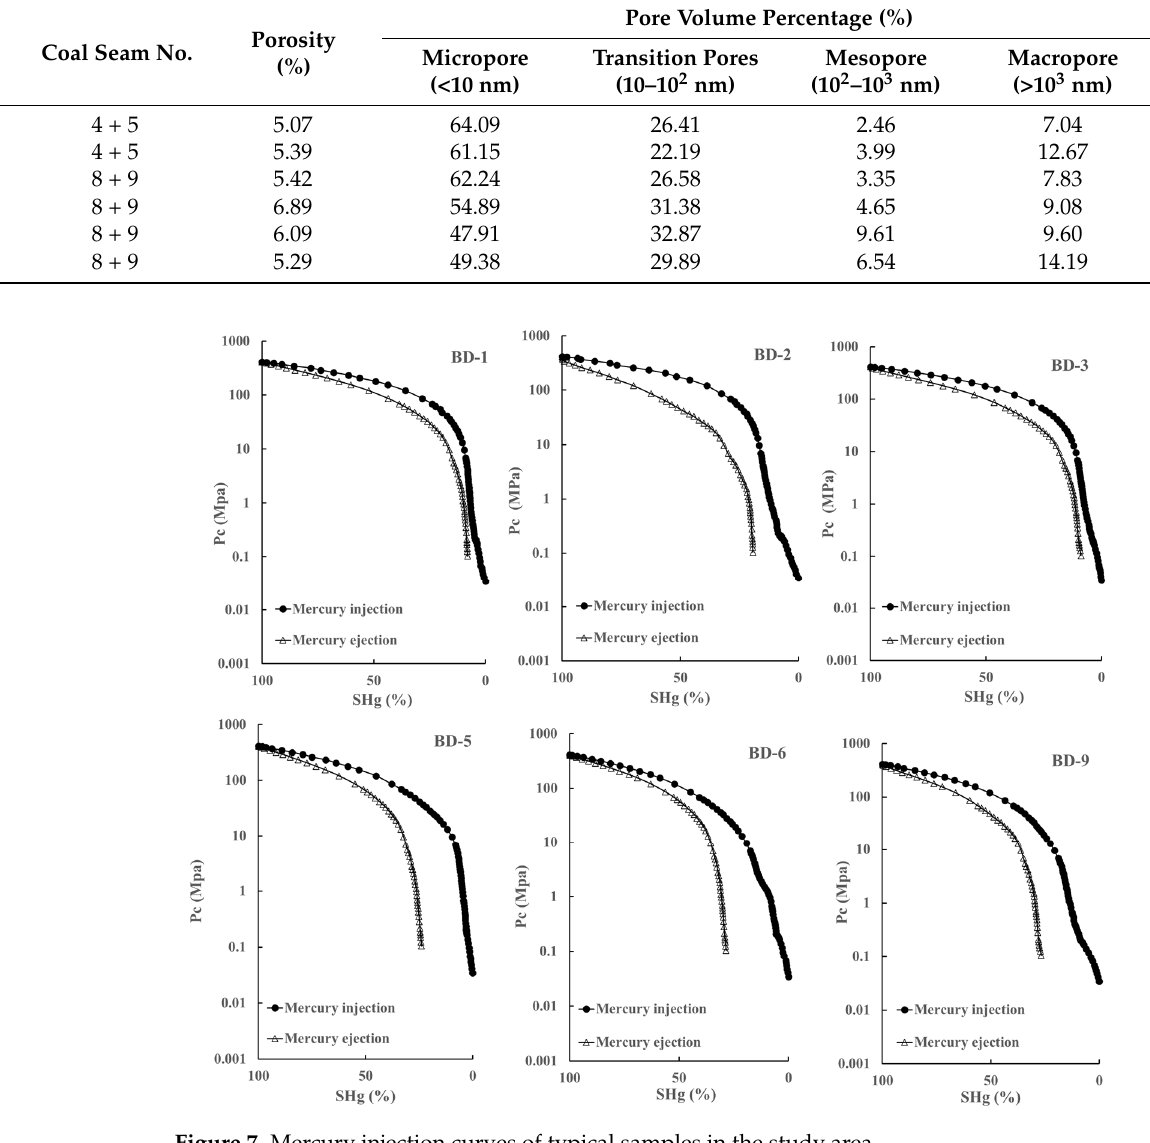
Figure 7. Mercury injection curves of typical samples in the study area.